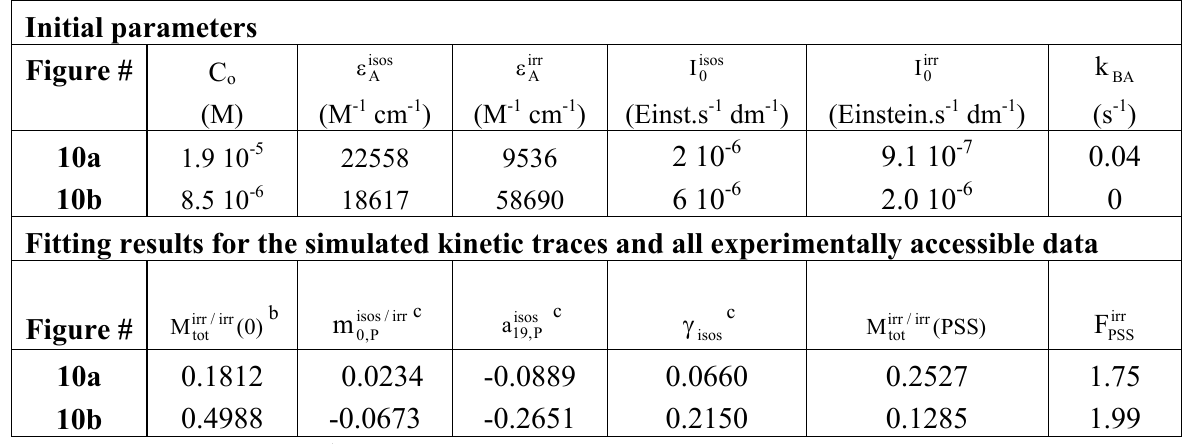
Table 3. Initial parameters a experimentally accessible data and fitting results for Figs.10a and 10b.